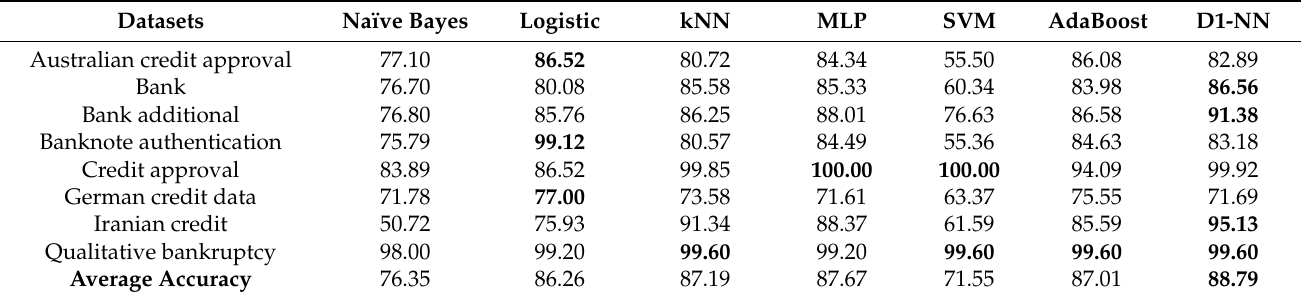
Table 3. Accuracy values (in %) obtained by the compared classifiers (best values in